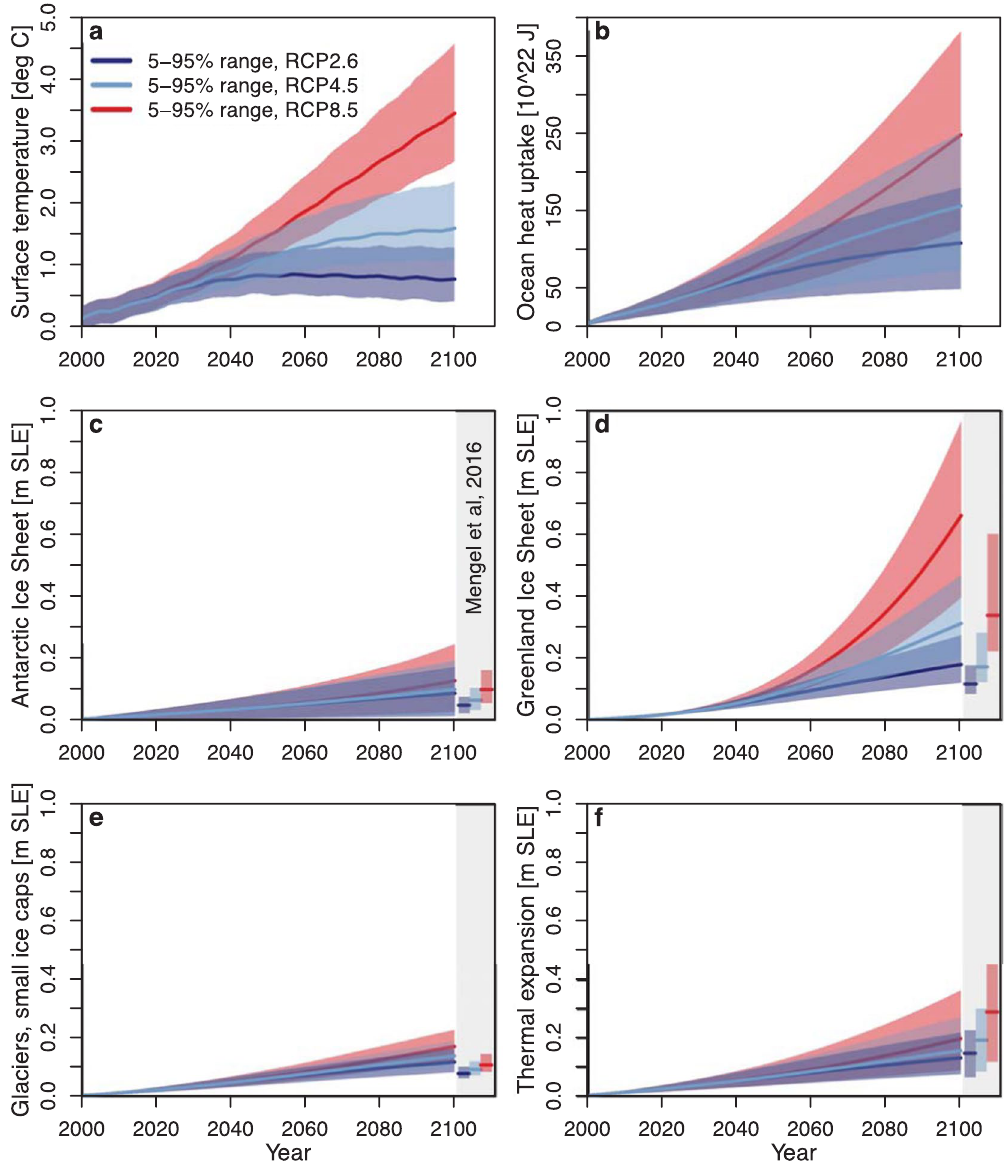
Figure 3. Future probabilistic projections of global temperature, ocean heat content and sea-level